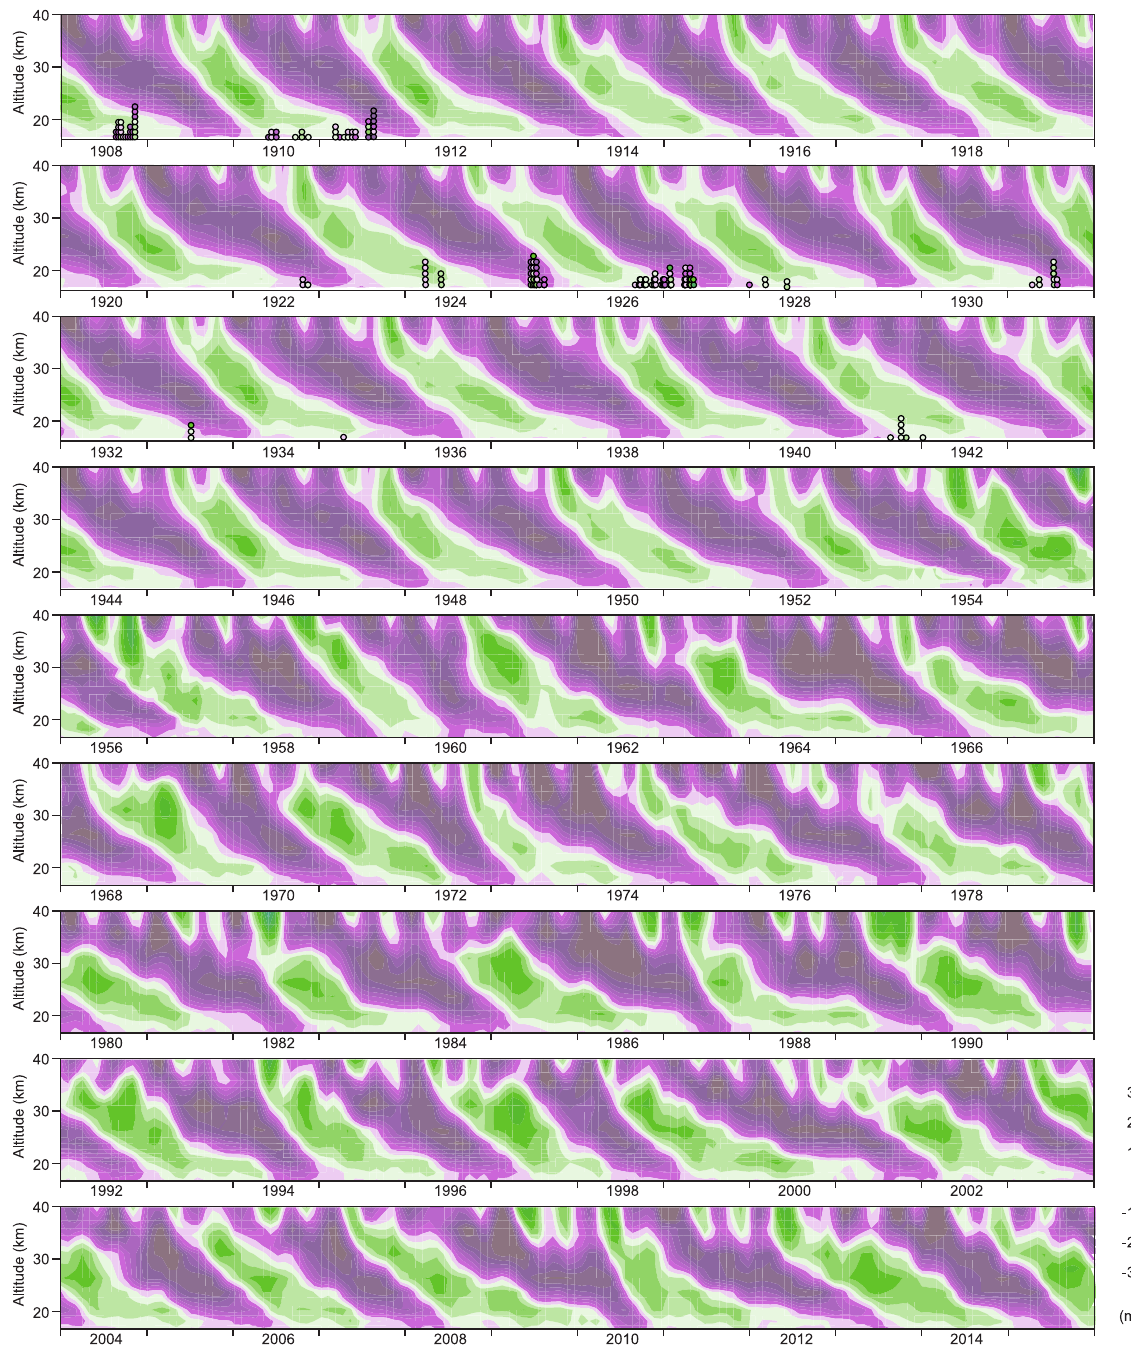
Figure 1. Hovmöller diagram (time–height cross section) of zonal-mean zonal wind at the equator from 1908 to 2015 (from Brönnimann et al., 2007). The dots in the first three rows indicate the additional wind data rescued within the ERA-CLIM